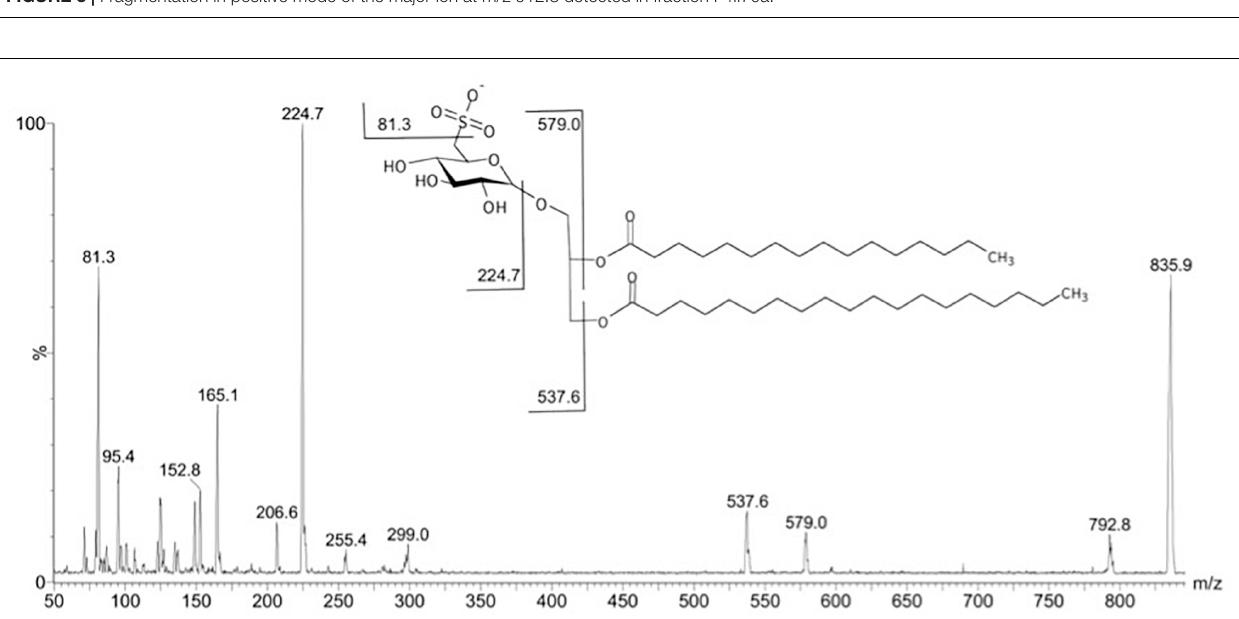
FIGURE 4 | Fragmentation in negative mode of the major ion at m/z 835.9 detected in fraction F4II70b.